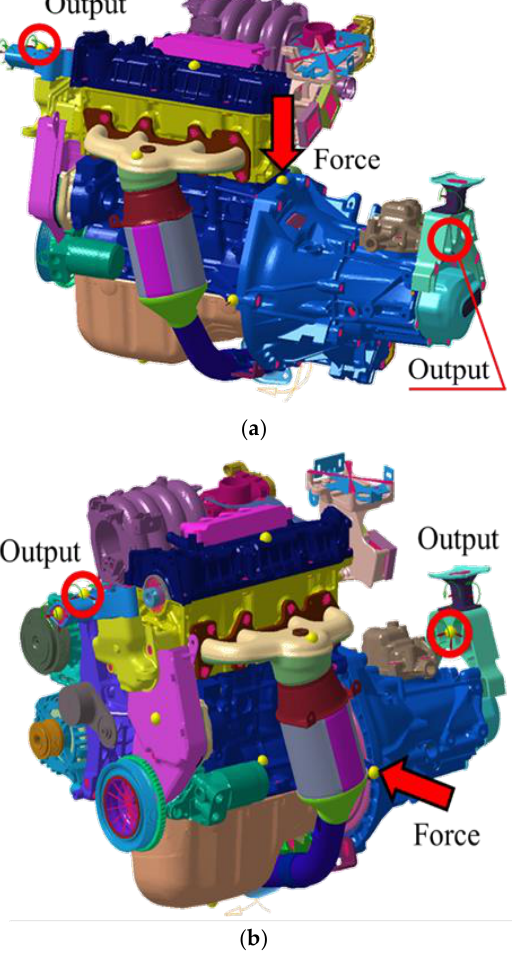
Figure 2. Full FEM model with details of the relevant points for the FRF analyses for load cases of ( a ) vertical bending and ( b ) lateral bending.